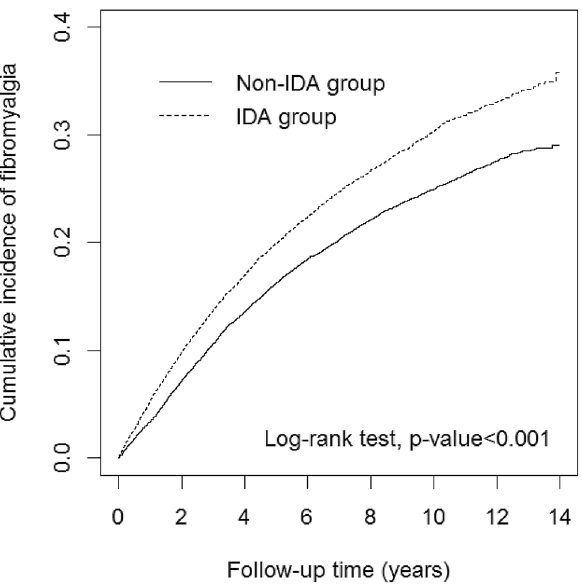
Figure 2. Cumulative incidence curves of fibromyalgia for groups with and without iron deficiency anemia. Abbreviation: IDA, iron deficiency